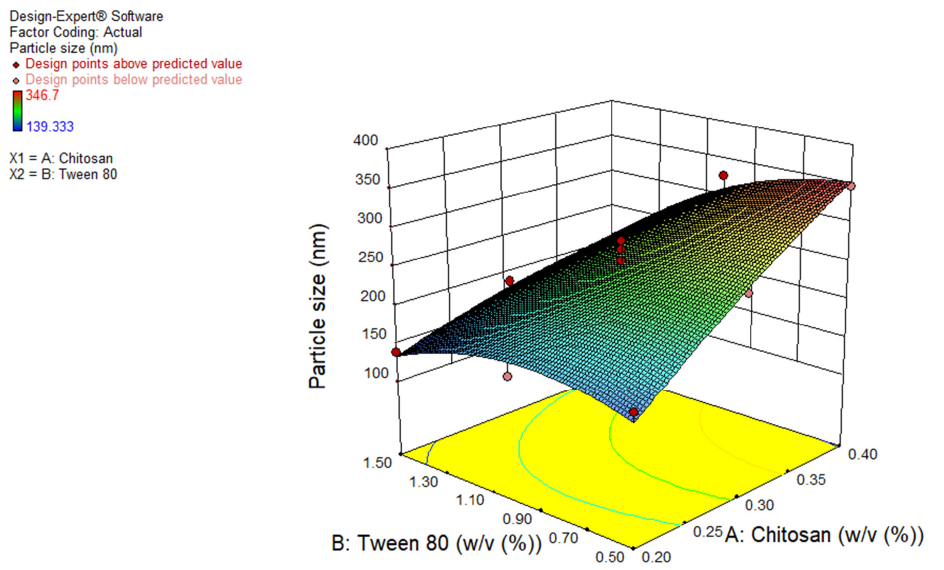
Figure 1. 3D surface plots showing effect of concentration of chitosan and tween 80 on size of TBN-CSNP.